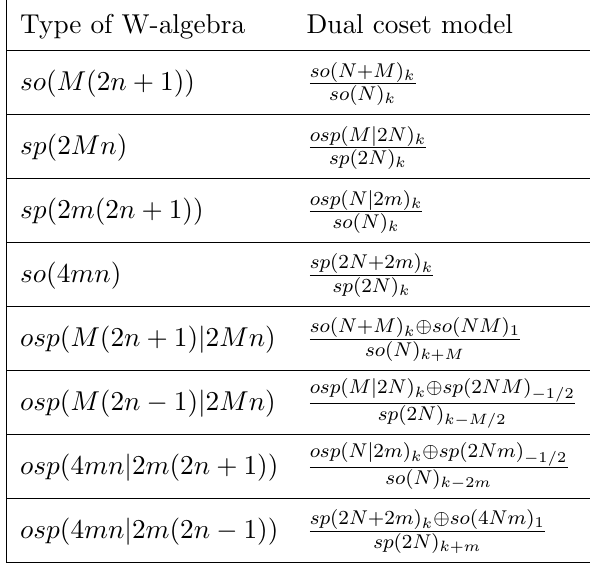
Table 2 . Our proposals on the coset models whose symmetries are realized by the rectangu- lar W-algebras. These W-algebras are obtained by the Hamiltonian reductions of the gauge (su- per)algebras and with the sl (2) (or osp (1 j 2)) embeddings listed in table 1. W-algebras as the symmetry algebras. We give the maps of parameters by comparing the central charges c and the levels ‘ ; ‘ of the a(cid:14)ne symmetries and explicitly construct low 1 2 spin generators of the symmetry algebras of the